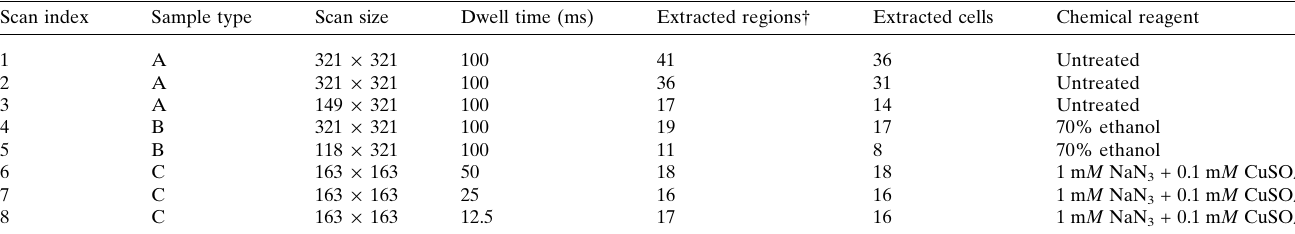
Table 1 Characteristics of the coarse scans collected at the 9-ID bionanoprobe of the APS. All coarse scans were collected under cryogenic conditions and have a resolution of 0.25 m